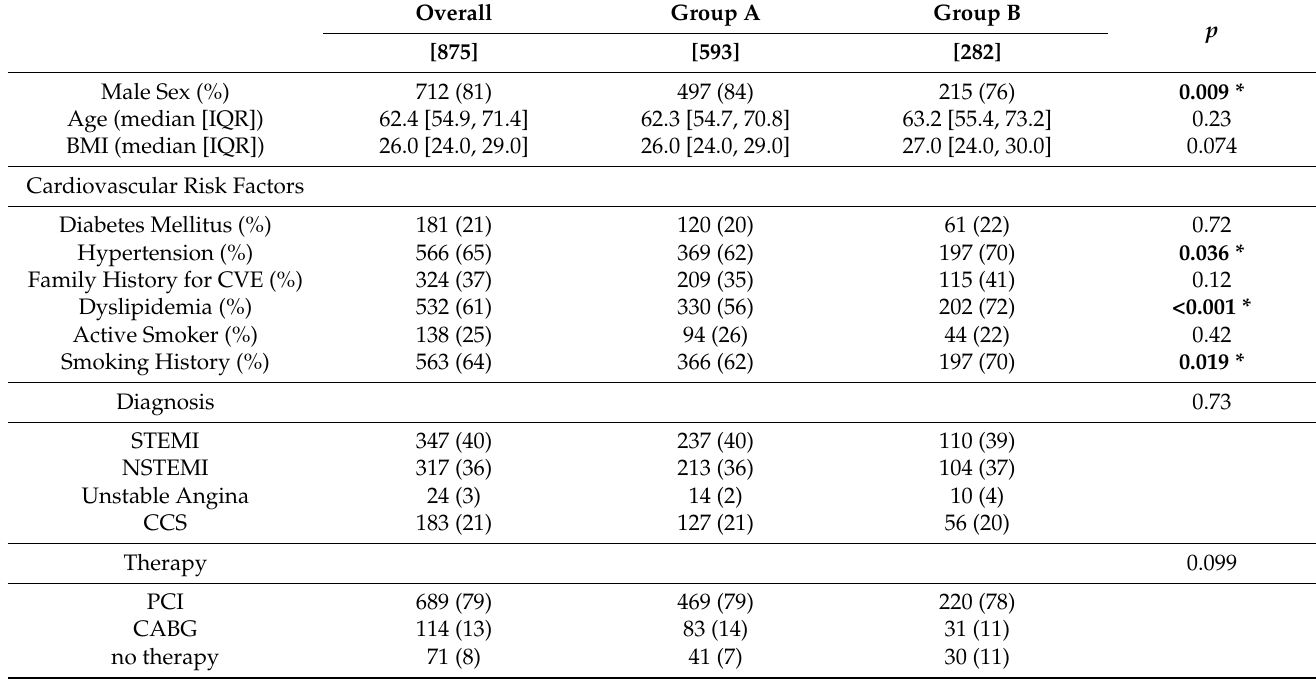
Categorical variables are described as n with % and continuous variables in median with interquartile range (IQR). Indication for significance = p Overall: 0.05 (indicated by bold letters and *); CABG: Coronary artery bypass surgery; CAD: Coronary artery disease; CCS: Chronic coronary syndrome; CVE: Cardiovascular Events; NSTEMI: Non-ST-elevation myocardial infarction; PCI: Percutaneous coronary intervention; STEMI: ST-elevation myocardial infarction.